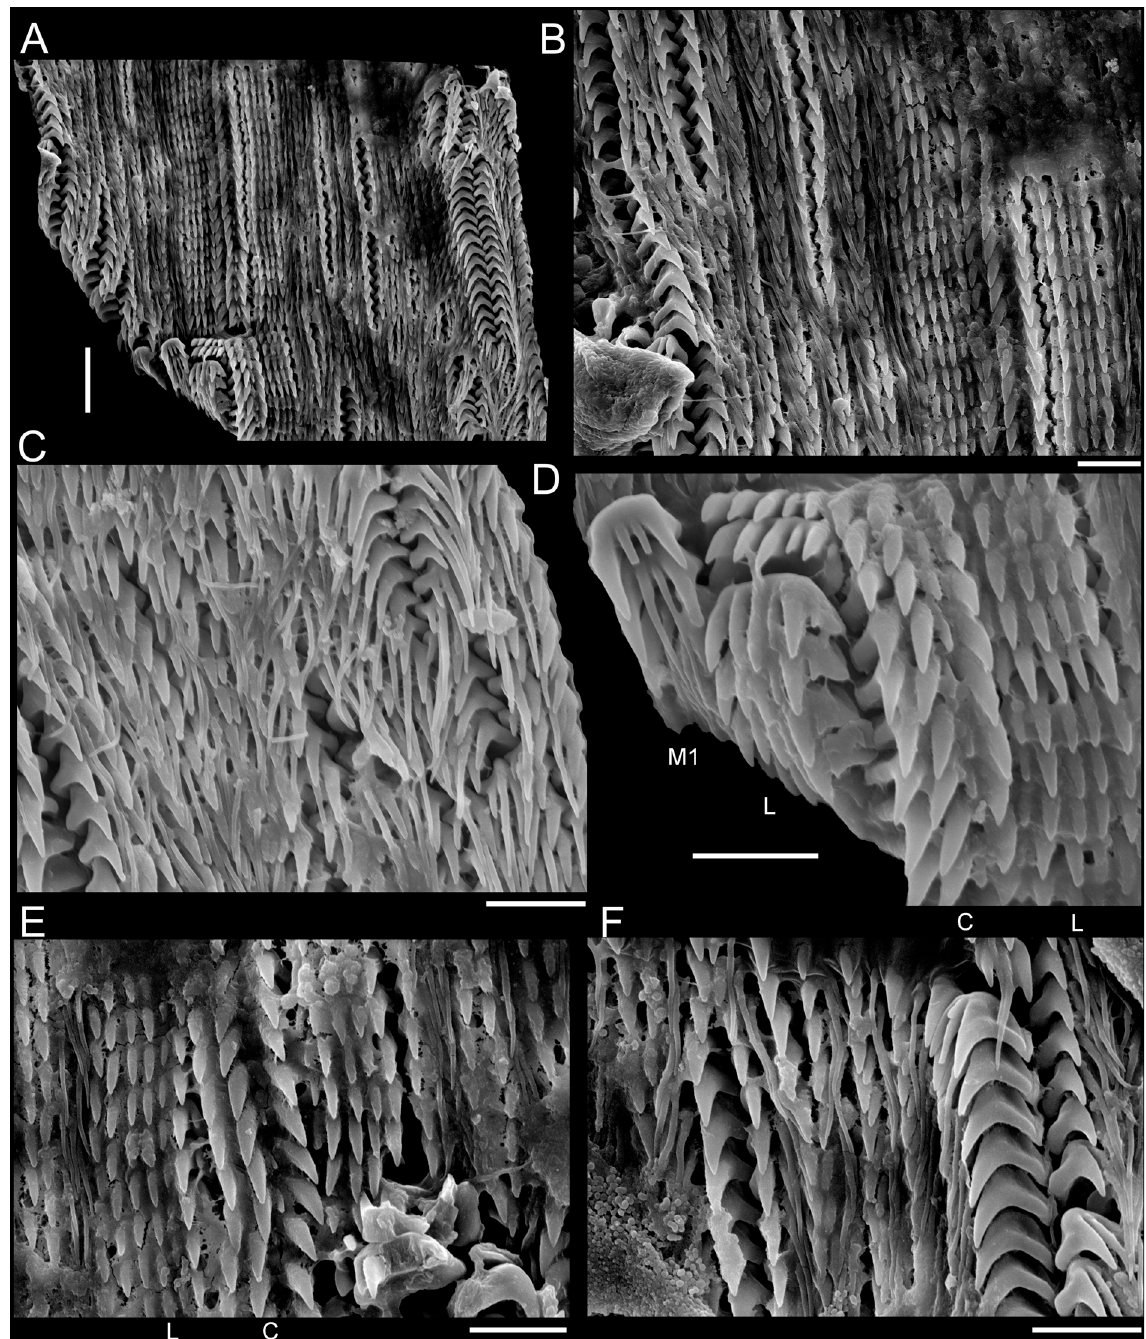
Fig. 13. Latitriphora albida (A. Adams, 1854), radula. A–F . BMSM 55442. Scale bars: A = 10 µm; B–F = 5